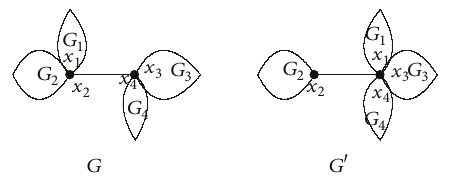
Figure 2: The graphs in Lemma